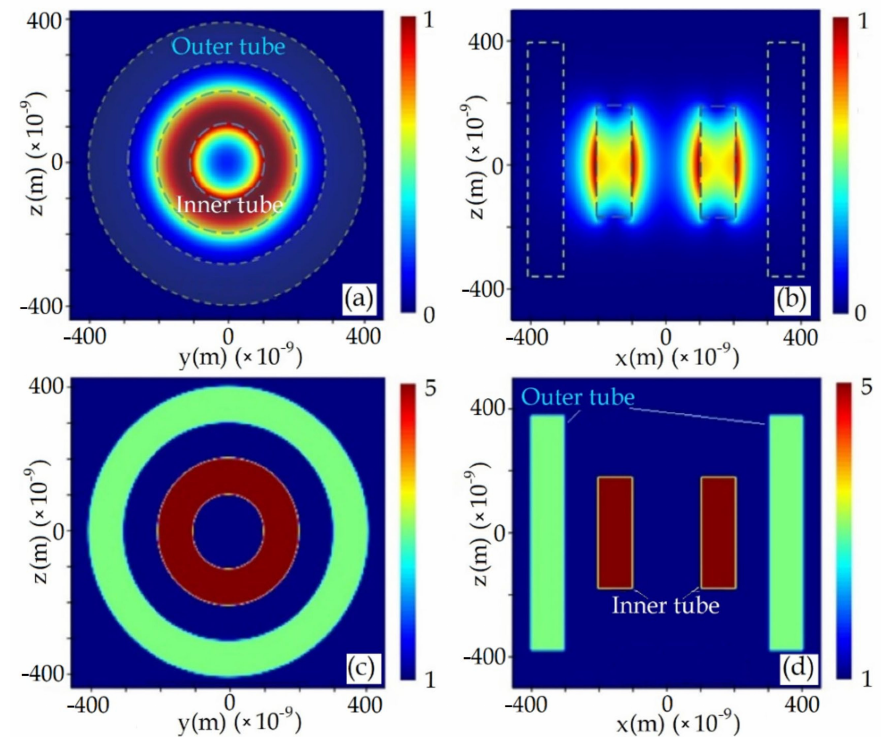
Figure 3. DWCNT’s EM field distribution maps’, ( a ) y-z plane view, ( b ) x-z plane view, and DWCNT’s material property parameters’ ( µ , ε ) distribution maps’, ( c ) y-z plane view, ( d ) x-z plane view.